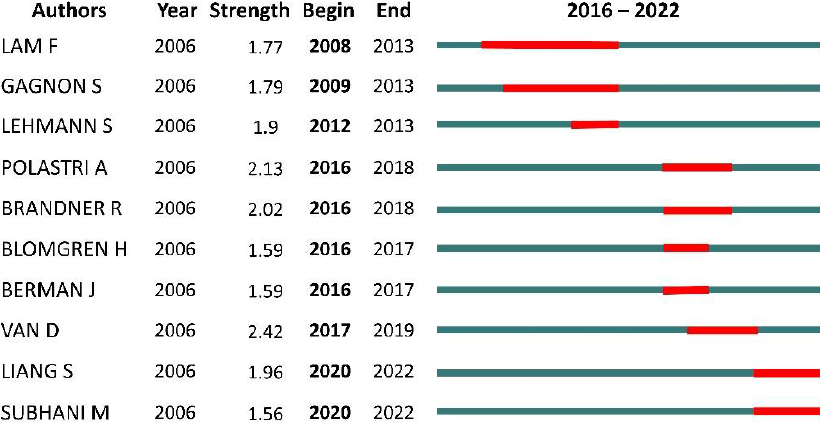
Figure 9. List of the top authors with relevant co-citation bursts.